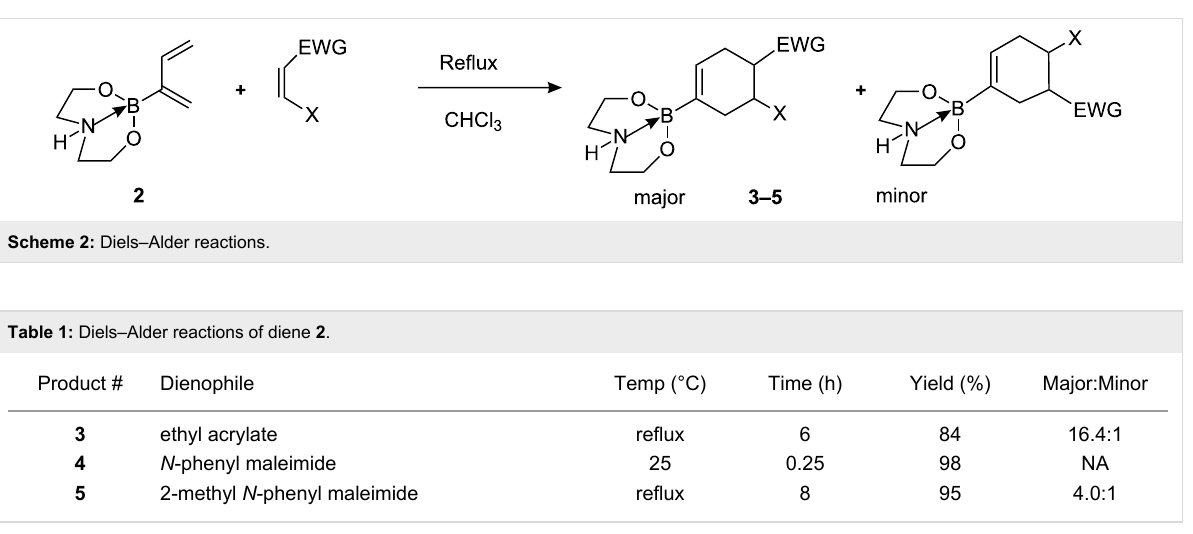
This diethanolamine boronyl diene 2 has proved to be signific- antly more reactive and more regioselective in Diels–Alder reactions compared to its BF 3 diene counterpart (Table